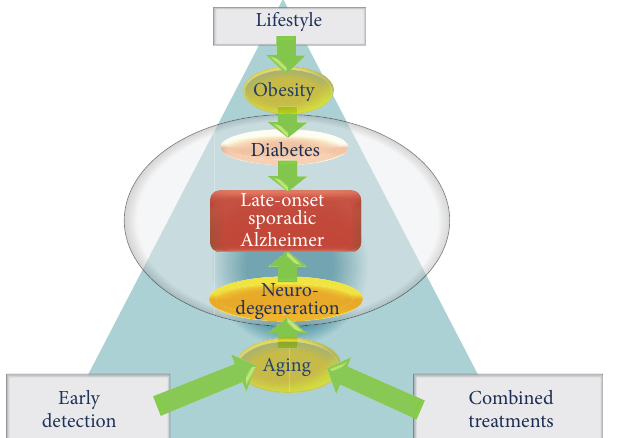
Figure 1: Future strategies in the treatment of late-onset and sporadic forms of AD could be centered on three main points: avoidance of habits and lifestyle leading to obesity and diabetes; early detection of AD biomarkers or structural alterations in presymptomatic individuals; and combined therapies in early phases of cognitive